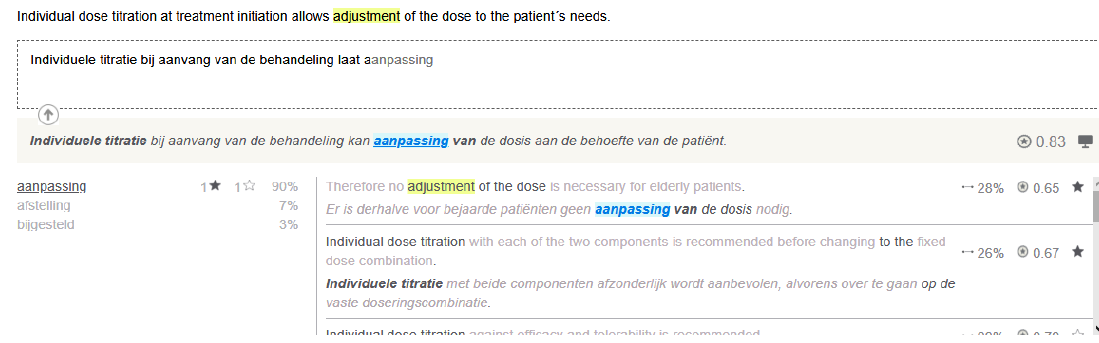
Figure 2. Fuzzy matches (bottom right) and integrated TM-MT suggestion (middle) in the prototype.